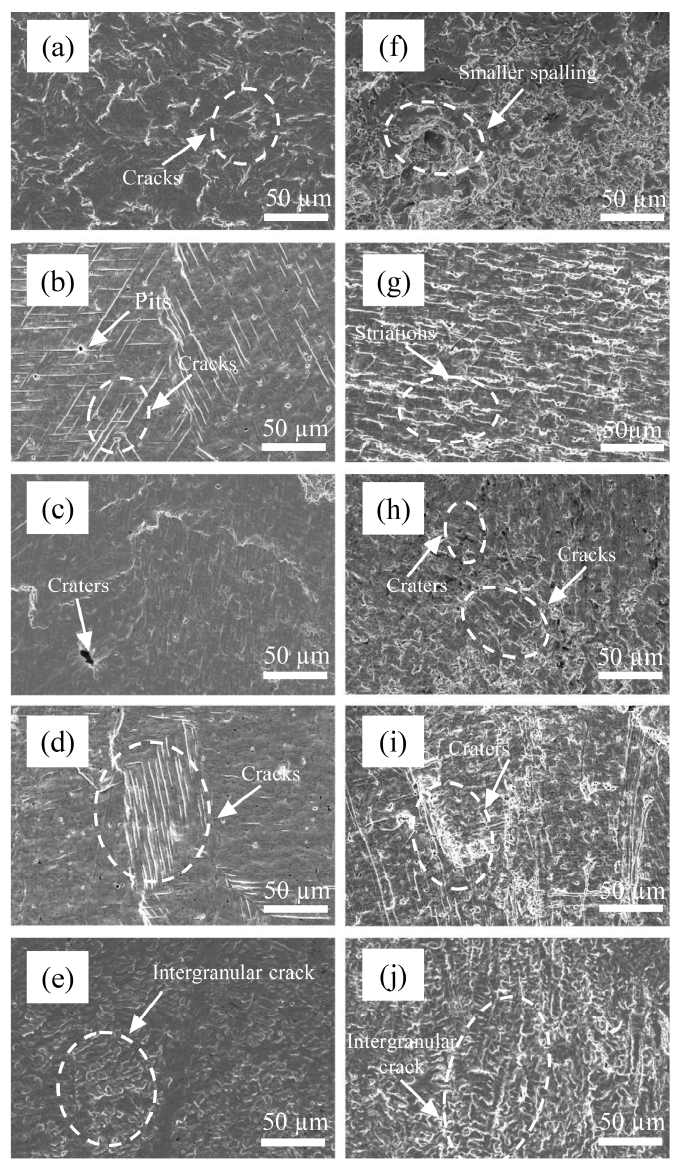
Figure 12. The surface morphologies of Cr20 ( b , g ), Cr25 ( c , h ), Cr20 ( d , i ), Cr20 ( e , j ), and 0Cr13Ni5Mo steel ( a , f ) after CE tests for ( a – e ) 2 h ( f – j ) 3 h in distilled water.